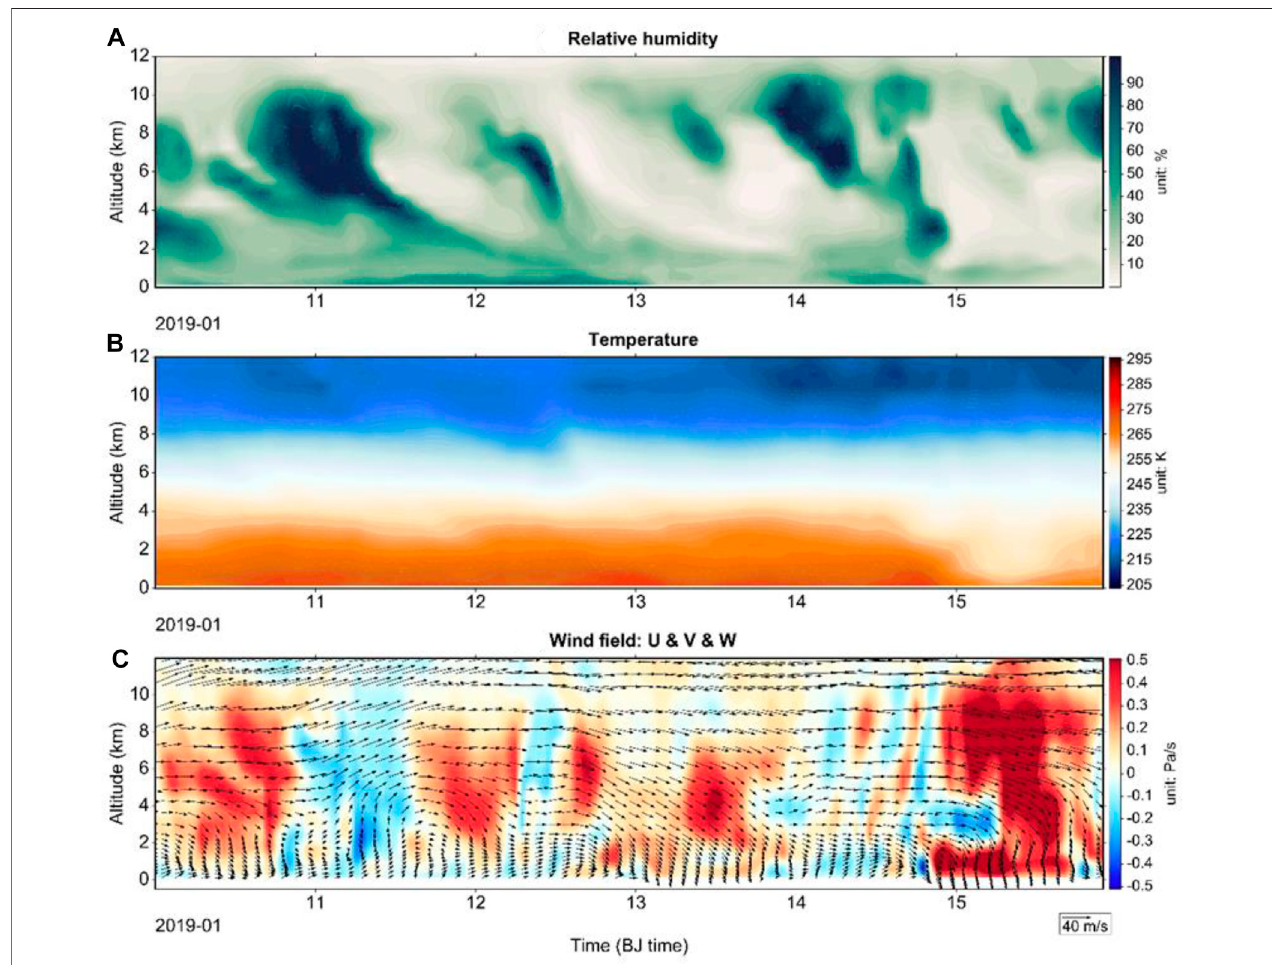
FIGURE 3 | Time – height distribution of (A) RH, (B) temperature, and (C) WF from 10 to 15 January 2019 in Tianjin.